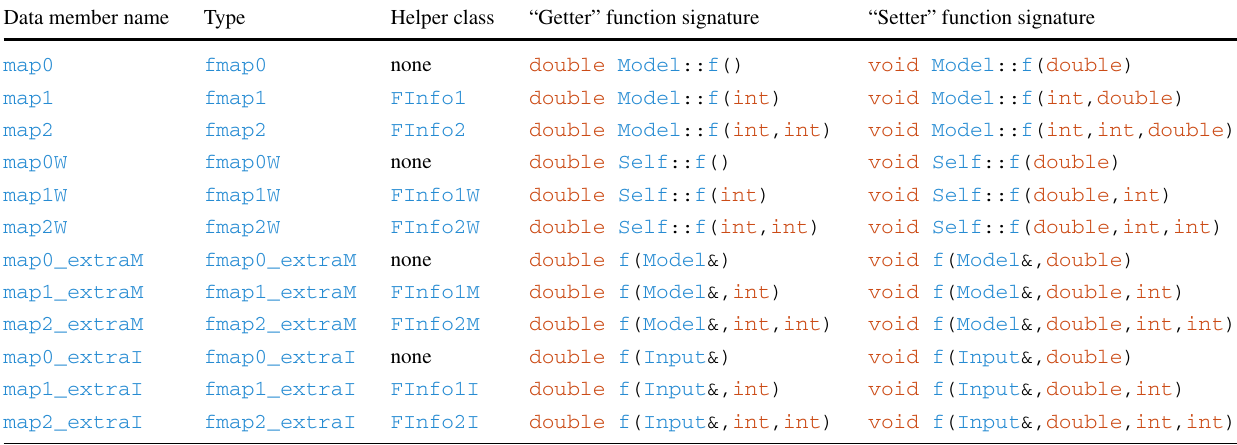
Table 15 List of data members of the GetterMaps and SetterMaps classes (which are std::map s), and the correspond- ing signatures of function pointers which can be stored in those maps. Note, however, that functions requiring index input cannot be stored directly in the map; they must first be associated with sets of allowed